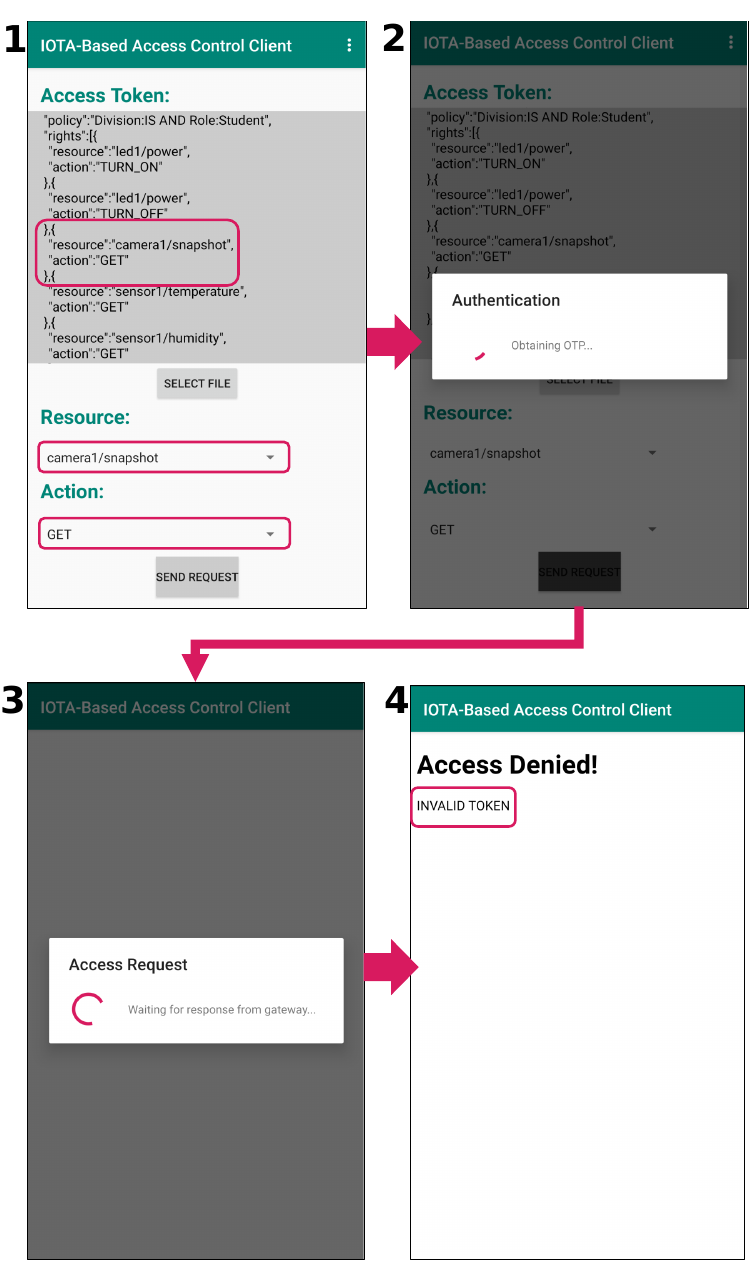
Figure 14. Denied access due to tampered